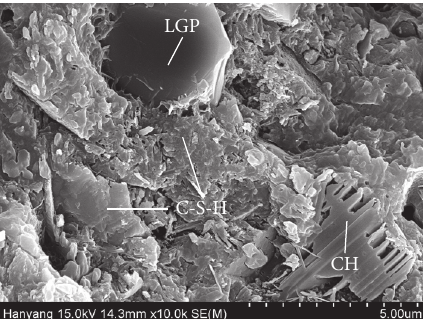
Figure 12: SEM image of composition paste which contained LGP12 10% (28 days).